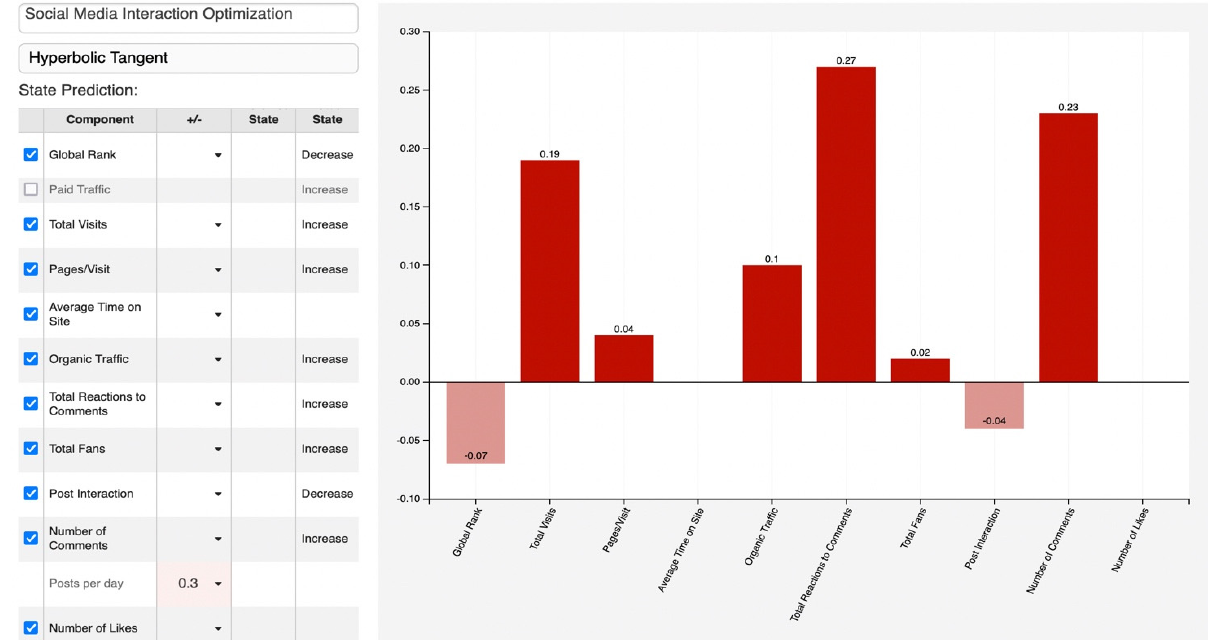
Figure 3. Social media interactivity optimization scenario.